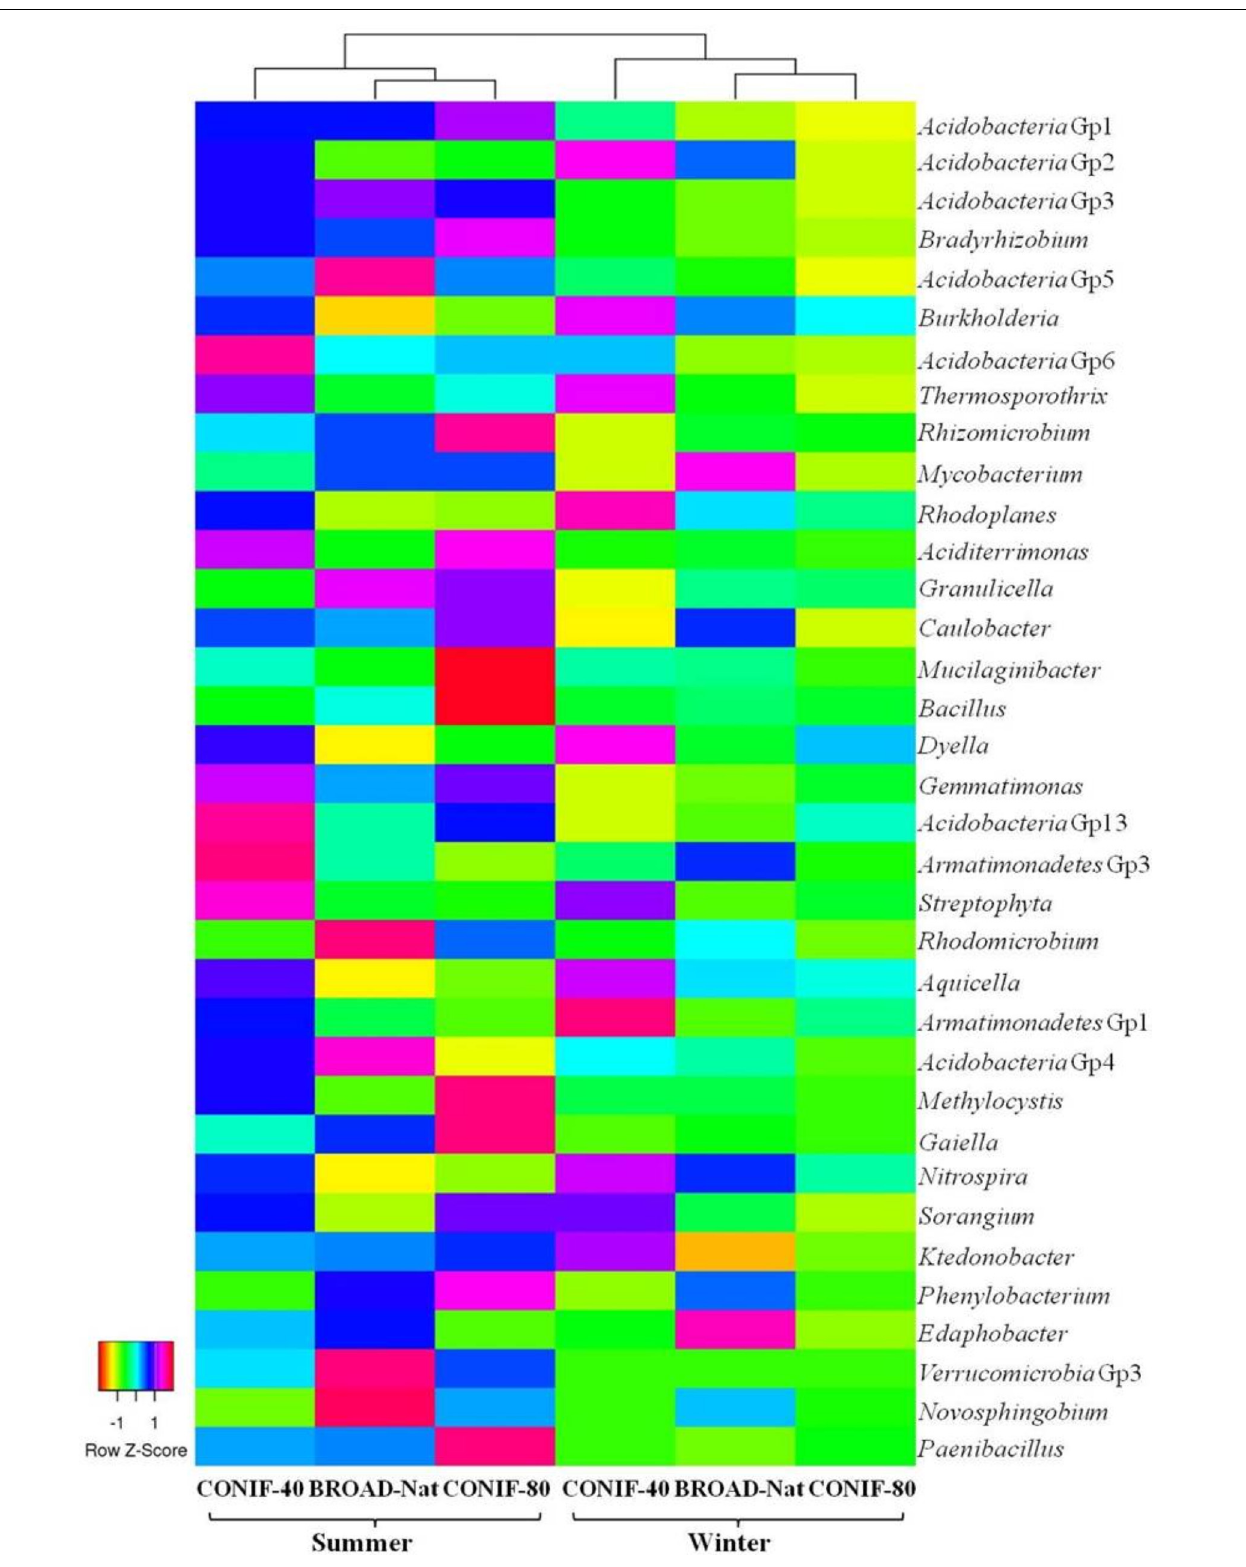
Frontiers in Microbiology |